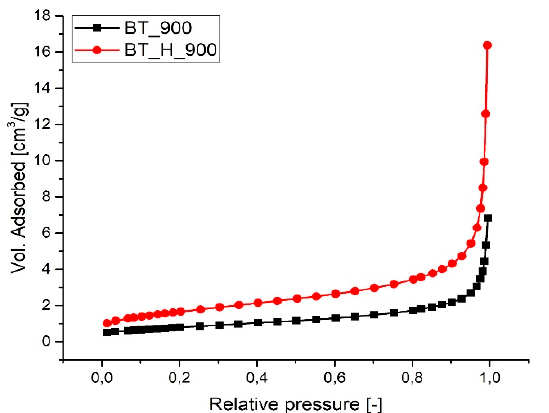
Figure 6. N 2 adsorption isotherms of BT_900 and BT_H_900.